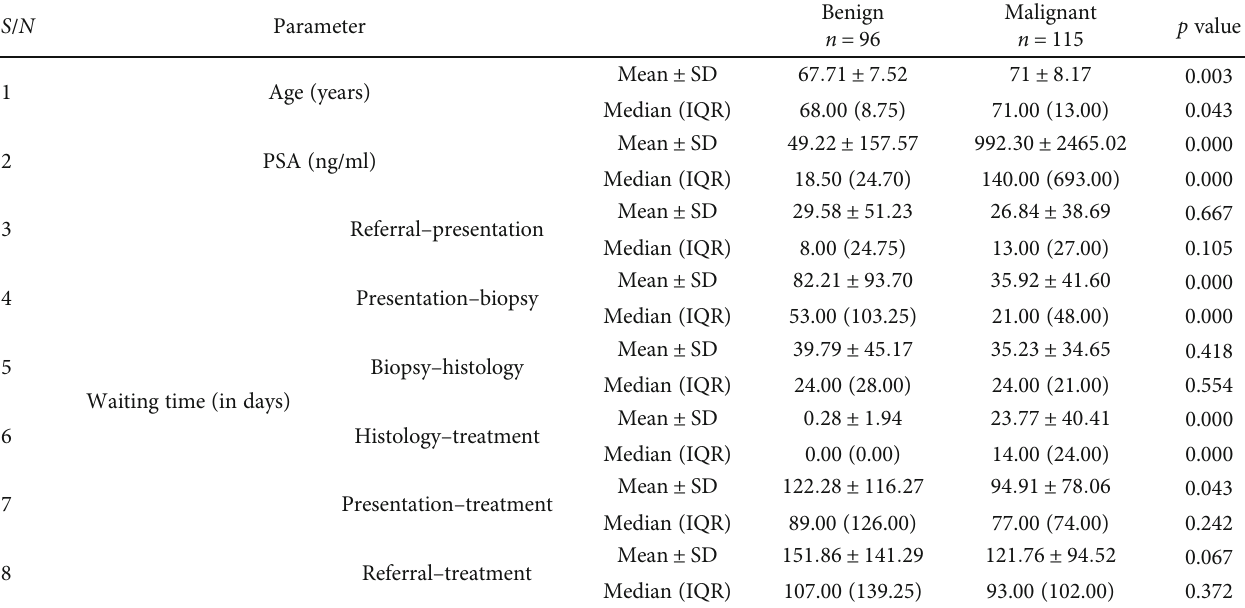
Table 2: Waiting times based on patient